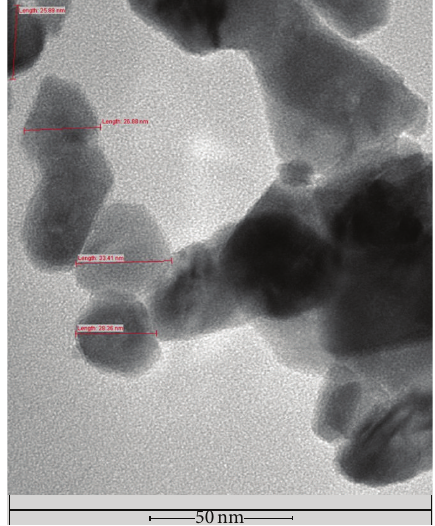
Figure 1: TEM micrograph of Co 3 O 4 with average grain size of 30 nm. Table 1: Zero-resistance temperature ( 𝑇 𝑐 ), volume fraction, critical current density ( 𝐽 𝑐 ) at 30 K, and 77 K in self-field. -zero 𝑥